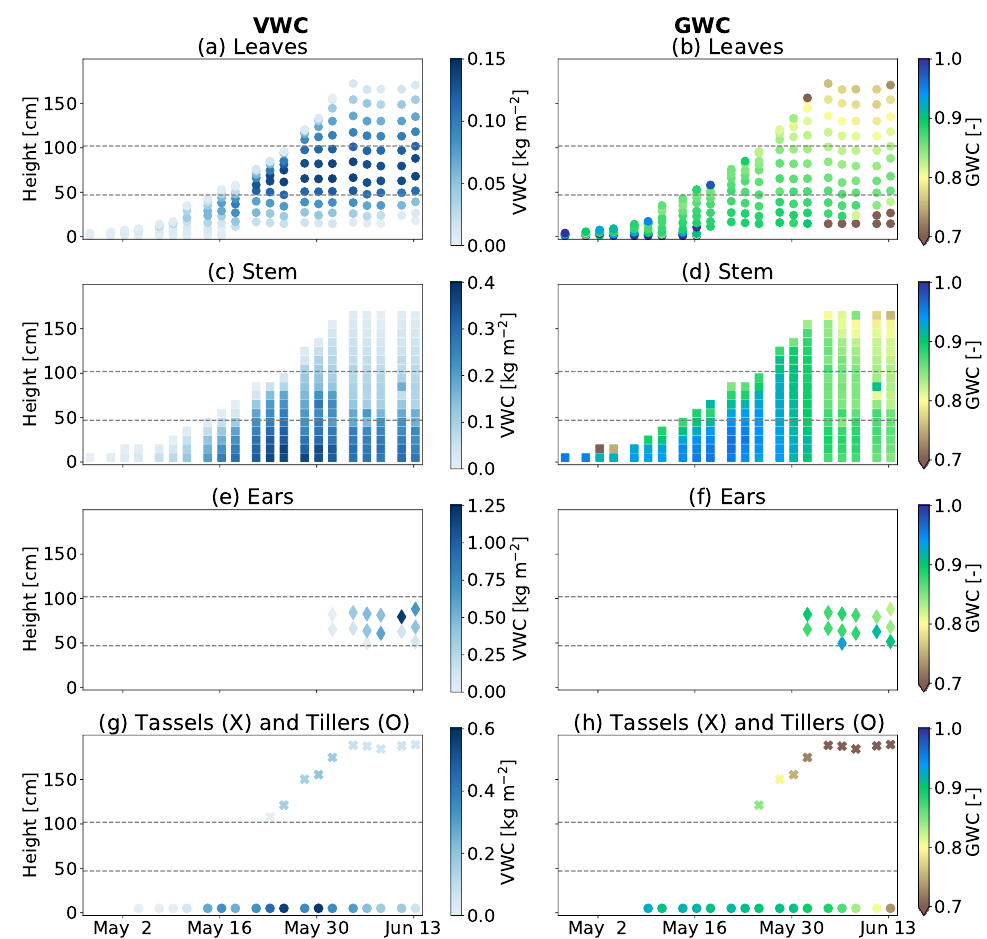
Figure 1. Vertical VWC ( left ) and GWC ( right ) profiles and their seasonal changes for sweet corn: with leaves ( a , b ); stems ( c , d ); ears ( e , f ); tillers ( g ); and tassels ( g , h ). Each marker is the average of 8 plants at a certain height from the ground. Note that the VWC-axes are different among the constituents. The horizontal dashed lines represent the separation of layers for the water cloud model. The upper layer, layer 3, is up to twice as thick as the lower layers and has the lowest water content (Figure 2. It contains the tassels, four leaves and the thinnest part of the stem. Once the layer water content reaches its peak on 30 May, it stays relatively constant (Figure 2b). Despite the decrease of their GWC, leaf and stem VWC remains 0.2 and 0.3 kg m − 2 , respectively. This can be explained by the growth of the leaves and stems in this layer and the distribution of water over increasing biomass. Tassel VWC decreased from 0.15 kg m − 2 on 25 May to 0.06 kg m − 2 on 13 June.